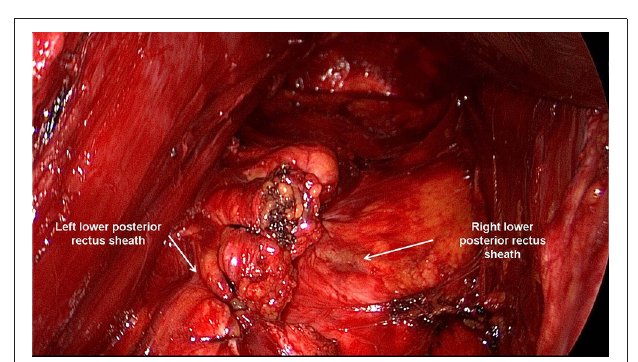
FIGURE 12 | The non-absorbable mesh (TiMesh strong) is placed between the rectus abdominis muscle, the ribs and xiphoid process and the reconstructed posterior rectus